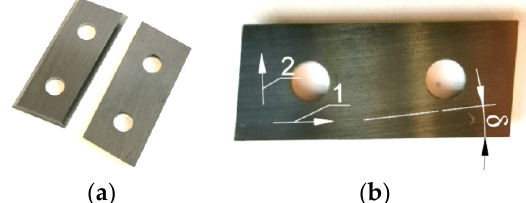
Figure 1. Specimens: ( a ) Hard metal WC-Co (Co 6%) cutters; ( b ) Angle between the polishing trace and the cutting edge δ; 1: direction parallel to the cutting edge; 2: direction perpendicular to the cutting edge (the slip direction of the chip on the rake face). Table 2. Characteristics of physical vapor deposition (PVD) coatings Table 1. Hard metal characteristics [40].